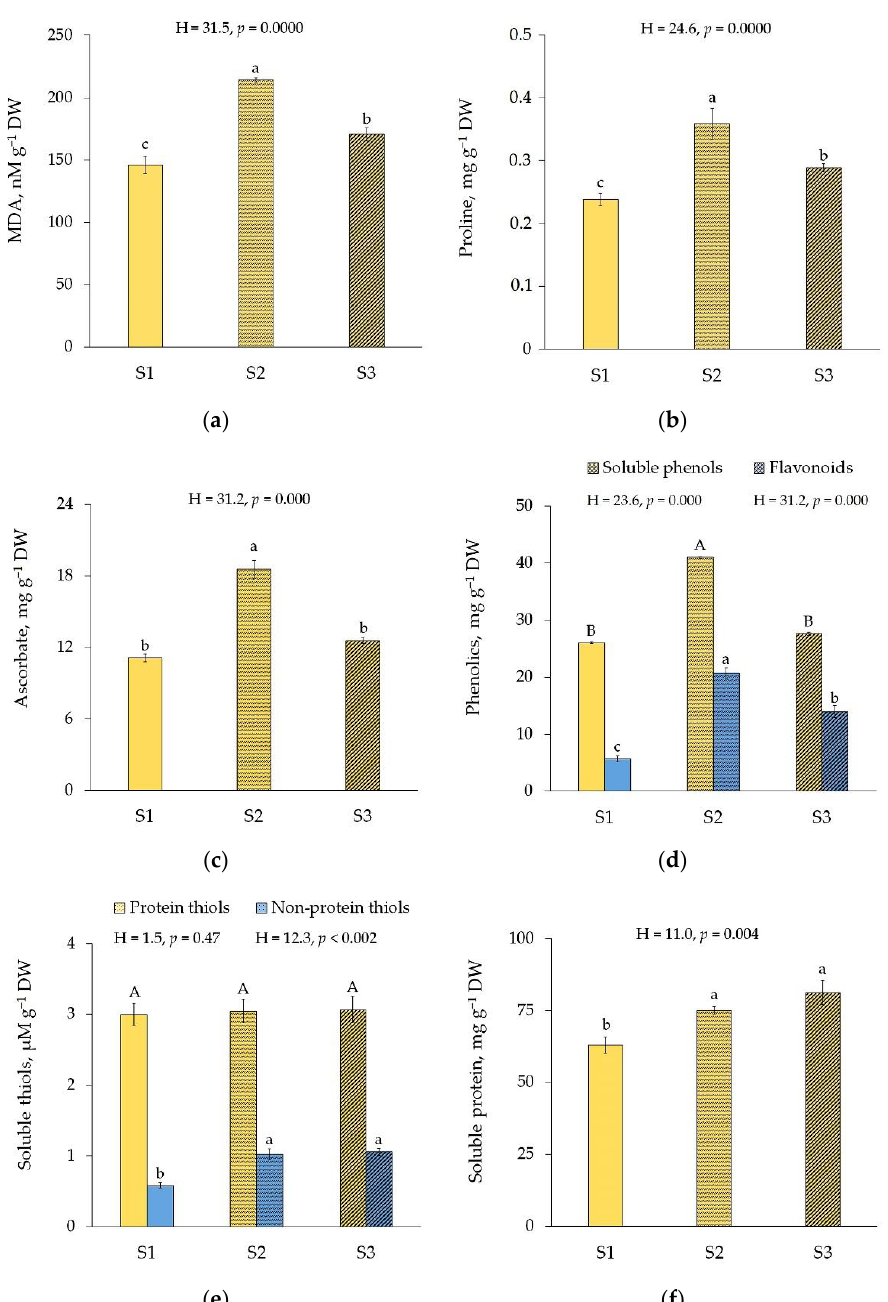
Figure 6. Pro- and antioxidant compounds in the leaves of E. atrorubens growing on serpentine substrates: ( a ) Malondialdehyde (MDA); ( b ) Free proline; ( c ) Ascorbate; ( d ) Soluble phenolics; ( e ) Soluble thiols; and ( f ) Soluble protein content. Data is presented as Means ± SE ( n = 12). Different alphabetical letters indicate a significant difference between the studied populations at p < 0.05.